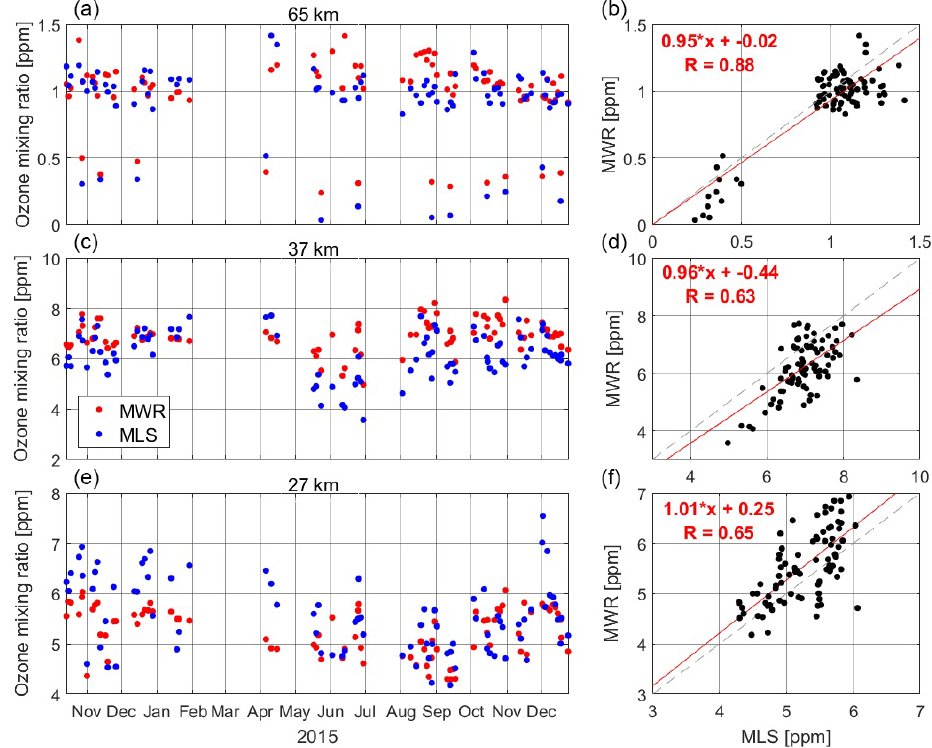
Figure 5. (a, c, e) MLS (red dots) and MWR (blue dots) ozone mixing ratios at the same time and within a box of ± 0 . 2 in latitude and ± 5 ◦ in longitude from the OAPA location for three altitudes: 27, 37, and 65km. The analysed period covers from October 2014 to December 2015, with a total of 84 overlap measurements; (b, d, f) scatterplot between MLS and MWR measurements for the three altitudes analysed. Table 1. Statistical parameters of the MWR with respect to the MLS and DIAL measurement inter-comparison. Intercept Alt. N Slope Intercept (vmr (ppm)) R MBE MWR–MLS 27km 84 1.01 0.24 0.65 + 5% 37km 84 0.96 − 0.43 0.63 − 11% 65km 84 0.95 0.02 0.88 − 7% MWR–DIAL 27km 30 0.93 0.36 0.73 −